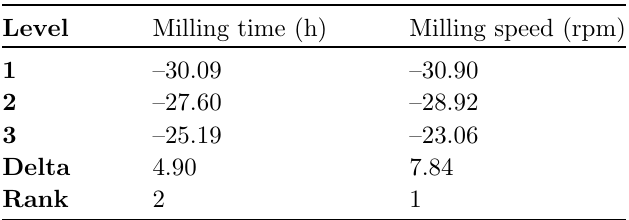
Fig. 3. Interaction plot for crystallite Table 4. Crystallite size (cid:2) response table for S/N ratios when smaller is better.